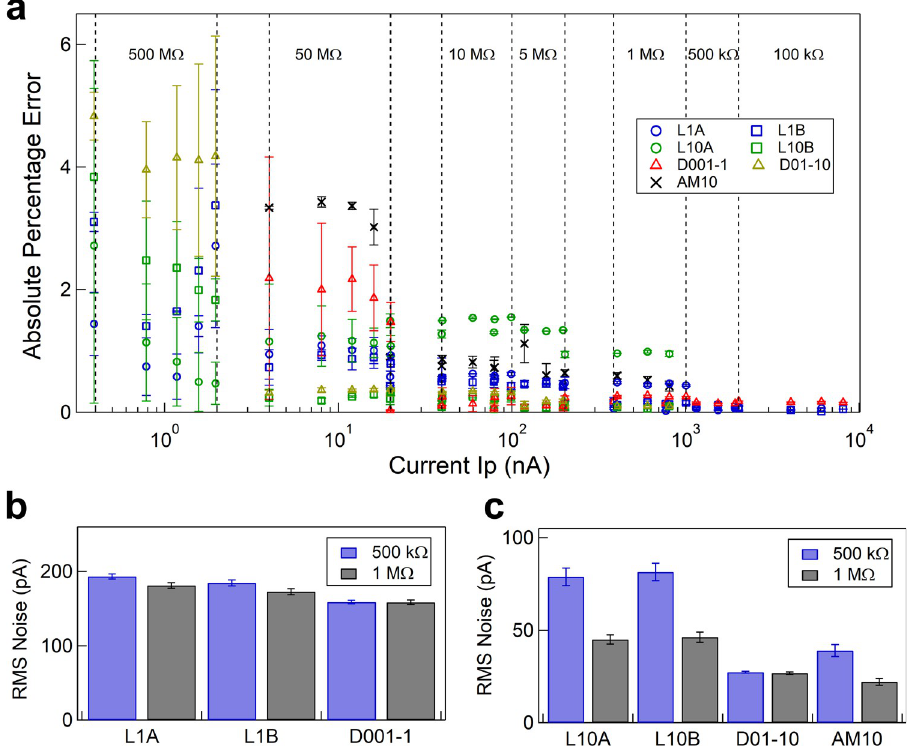
Fig 2. Comparison of absolute percentage error and RMS noise in current with different amplifiers. a Absolute error percentage in the measured current as defined in Eq (1), is plotted against the expected current for different amplifiers. Note that the current was measured at both positive and negative voltages to get an absolute mean current value and errorbars. Blue and green markers are for lab-amplifiers and red, yellow and black are for commercial amplifiers. b and c show RMS noise and the error bar values (at 1 kHz) in the current, measured at ± 300 mV for R P = 500 k Ω (blue) and 1 M Ω (grey), by different amplifiers with feedback resistor (R F ) values 1 M Ω (b) and 10 M Ω (c). A 600 ms current series was recorded at 100k sample/sec, 10 such sets at ± 300 mV were used for estimation of RMS noise and respective errorbars. Online version in